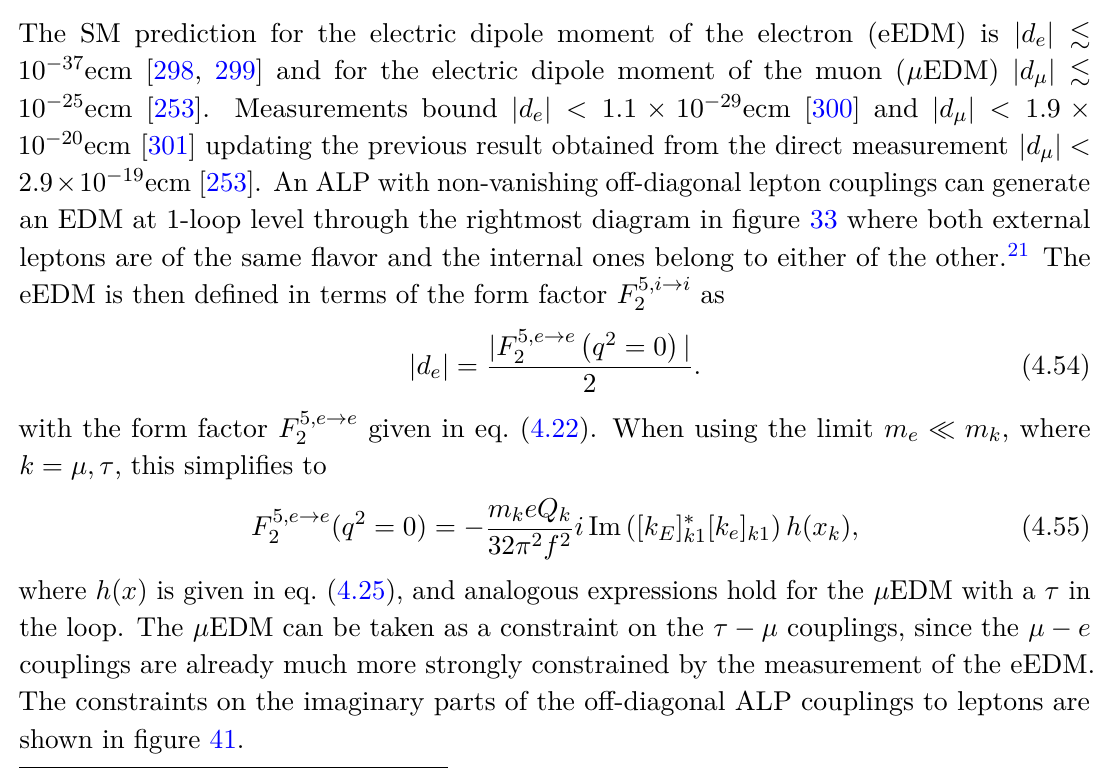
Figure 41 . Bounds from ALP induced EDMs with ˜ c ‘ universal ALP couplings to leptons c coefficients zero at tree-level. The limits on ˜ c from the µ